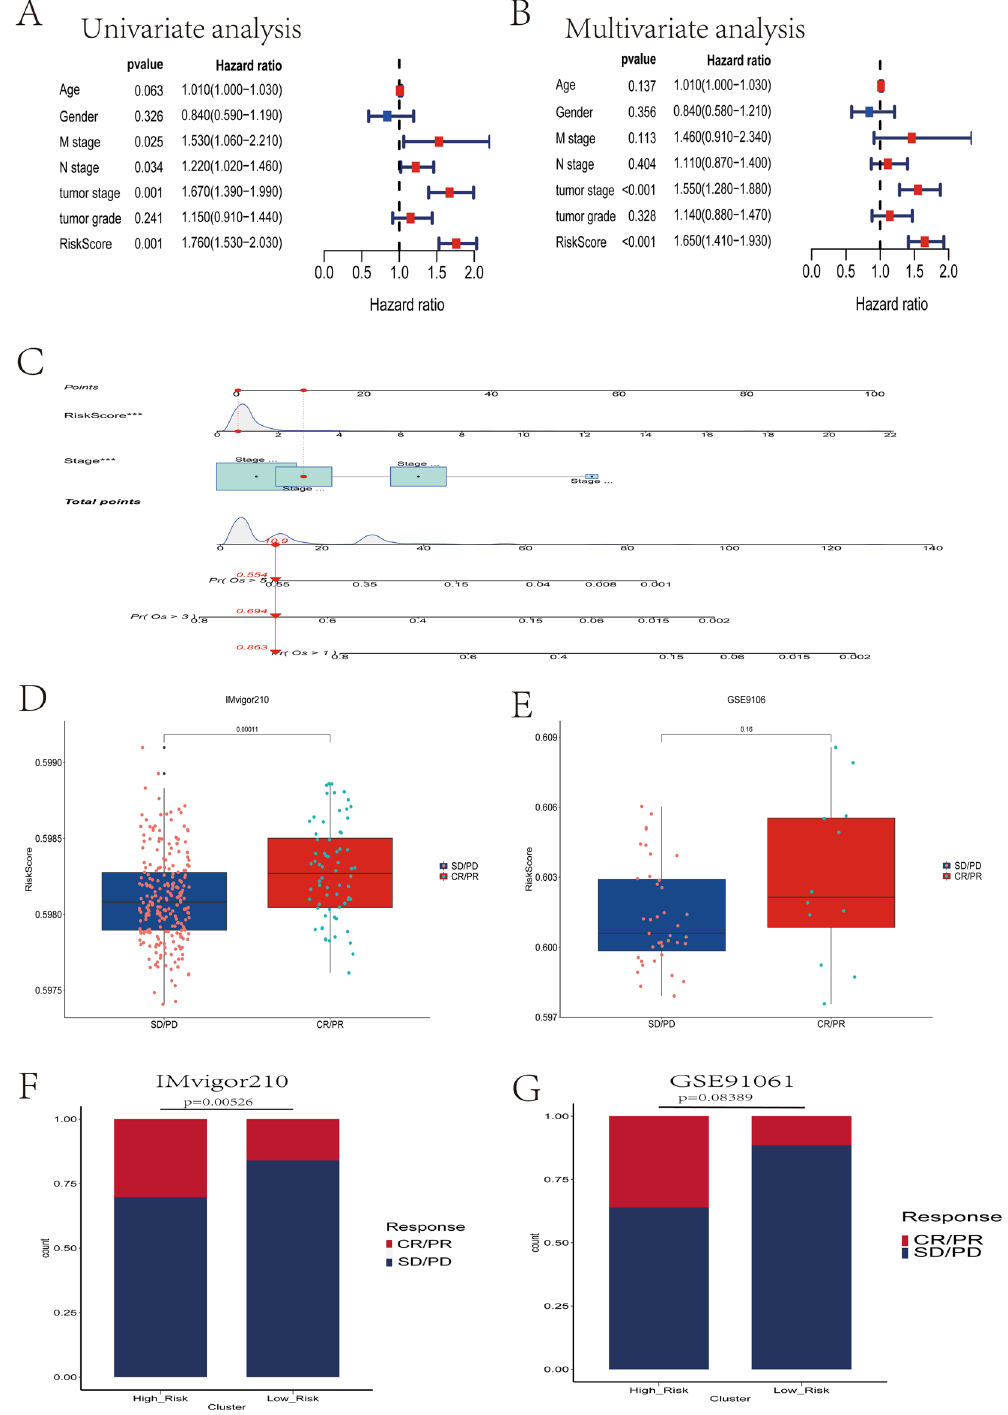
Figure 8. Construction of nomograms and validation of immunotherapy responses in multiple independent external datasets. ( A ) Results of univariate Cox regression analysis of risk scores and clinical characteristics. ( B ) Results of multivariate Cox regression analysis of risk scores and clinical characteristics. ( C ) Nomogram constructed from Stage and risk score. ( D ) In the IMvigor210 dataset, patients who responded to immunotherapy (CR/PR) had significantly higher risk scores than patients in the low-risk group. ( E ) In the GSE91061 dataset, patients who responded to immunotherapy (CR/PR) had a higher median risk score than patients in the low-risk group. ( F ) In the IMvigor210 dataset, the percentage of patients who responded to immunotherapy (CR/PR) was significantly higher in the high-risk group than in the low-risk group. ( G ) In the GSE91061 dataset, the percentage of patients who responded to immunotherapy (CR/PR) was higher in the high-risk group than in the low-risk